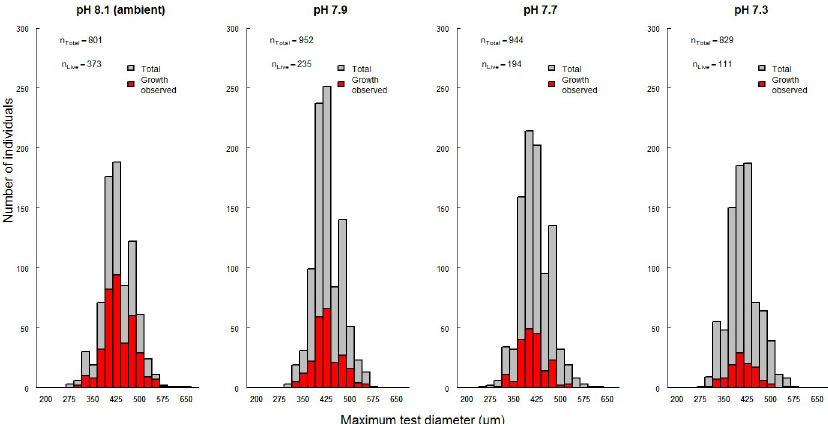
Fig 1. The total number of individuals of Elphidium williamsoni sorted into size classes after being collected at the end of the experimental period in each culture condition (pH 8.1 (ambient), pH 7.9, pH 7.7 and pH 7.3). The individuals analysed (n Total ) and live specimens (n Live ) observed are shown in grey and red, respectively. Bandwidth for each size class was 25 μ